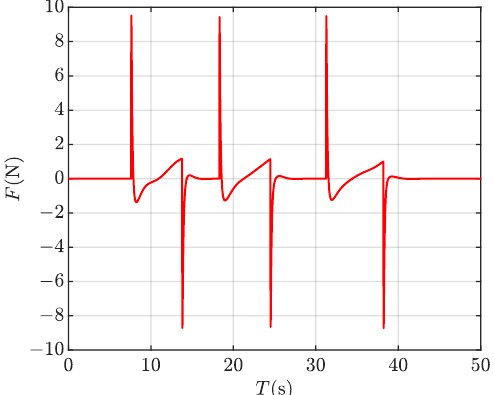
Figure 14. Disturbance force along the X-direction of the aircraft.